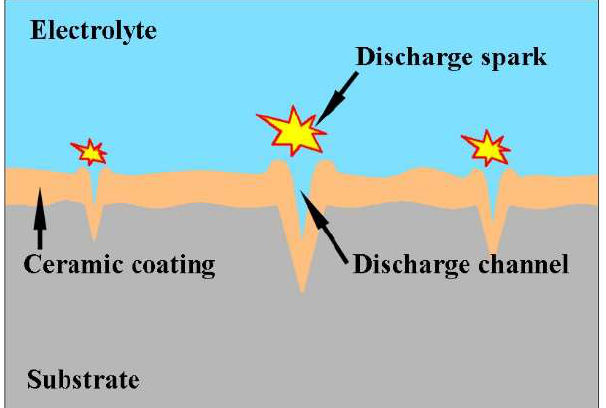
Figure 5. Schematic diagram of micro-arc discharge mechanism.